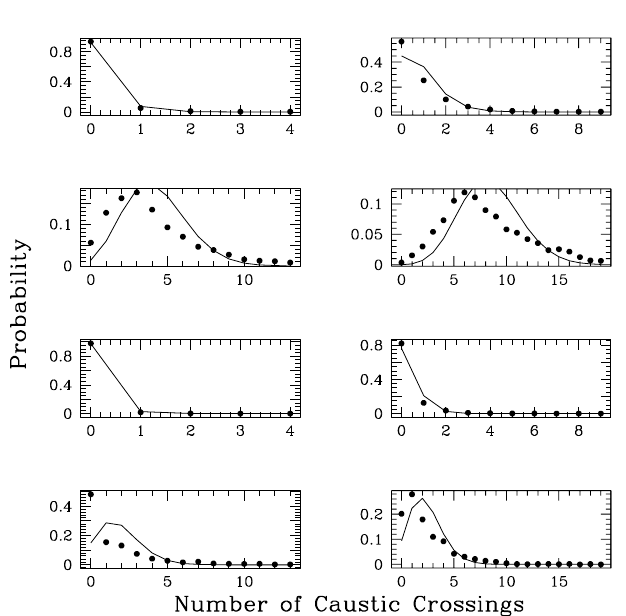
Fig. 3. Comparison between the simulated (dotted line) and binomial (solid line) probability distributions in the windows of 4, 40, 200 and 400 pixels. The (cid:12)rst and second raws: hypothesis I; the third and fourth raws: hypothesis